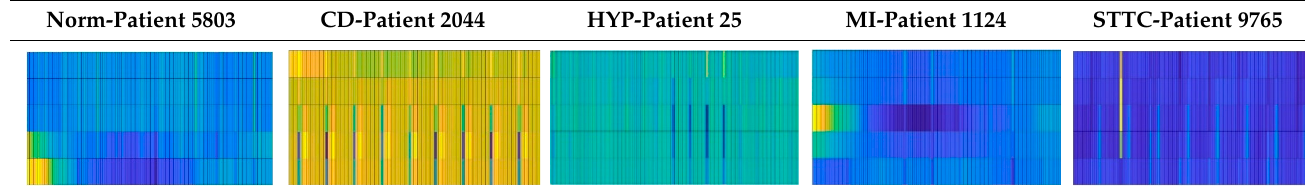
Table 3. Example of sECG images of Pyshionet in MATLAB for each of the classes. Norm-Patient 5803